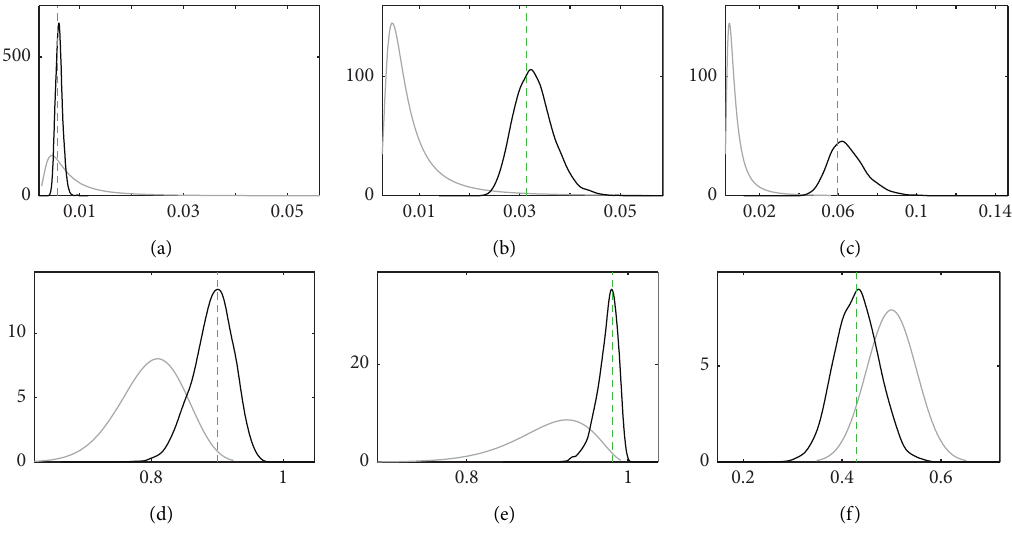
Figure 1: Priors and posteriors distributions. (a) SE_e_a. (b) SE_e_t. (c) SE_e_g. (d) rhoa. (e) rhog. (f) Table 3: Steady-state values of major economic variables in different scenarios.